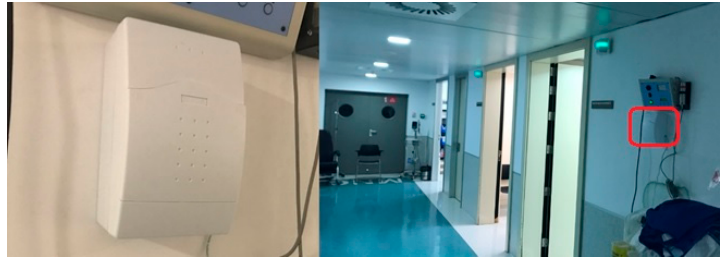
Figure 21. Device located in Positron Emission Tomography (PET) corridor.